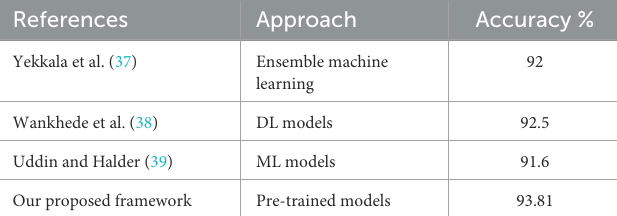
TABLE 4 Comparative accuracy of the proposed approach with previous proposed